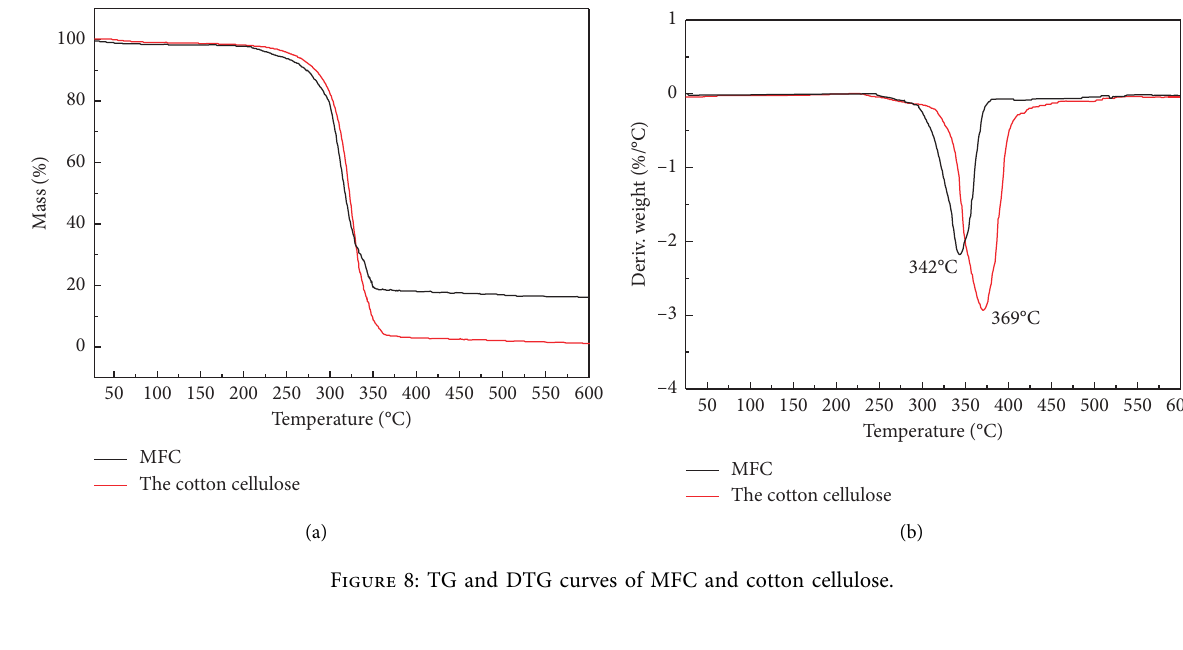
Figure 8: TG and DTG curves of MFC and cotton cellulose.